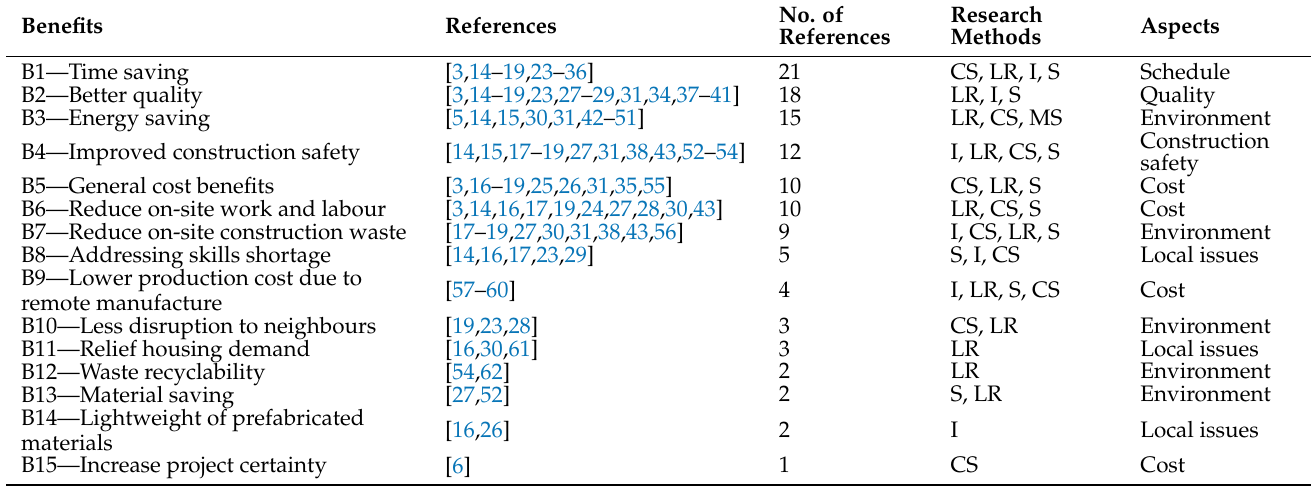
Table 2. Summary of previous research on the benefits of